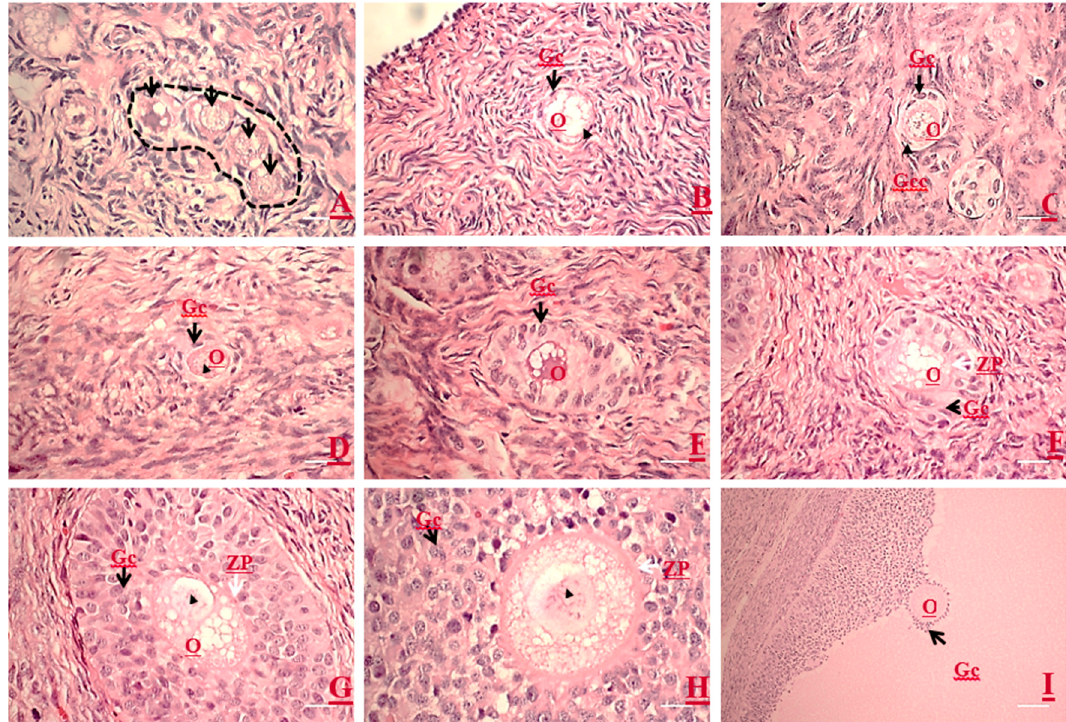
Figure 1. Microscopic morphologies of growing oocytes, follicles, and the associated follicular cells at different stages of folliculogenesis by using semi-thin sections of porcine ovaries. ( A ) A cluster of primordial follicles (enclosed in dot line) is observed in the cortex area. ( B ) Note the flattened granulosa cells (Gc) (arrow) are surrounding an immature oocyte, and the oocyte contains an eccentrically localized nucleus (arrowhead). ( C ) An activated primordial follicle: an oocyte is surrounded by two types of granulosa cells, i.e., cuboidal granulosa cells (arrow) at one pole and flattened granulosa cells (arrowhead). ( D ) A primary follicle oocyte is surrounded by a single layer of cuboidal granulosa cells (arrow), and the oocyte contains an eccentrically localized nucleus (arrowhead). ( E – H ) An early secondary follicle is transforming into a late stage secondary follicle with the onset of zona pellucida (ZP) formation (white arrow). Note that the increasing layers of cuboidal granulosa cells can be observed with no ZP structure ( E ), and all oocytes possess an eccentric germinal vesicle (GV nucleus, arrowhead). A very thin ZP ( F ) starts to form (white arrow). ( G ) The ZP is getting thicker as the granulosa layers increased. The granulosa cells start getting loosening while the ZP is thickening. ( I ) A tertiary follicle shows multiple layers of polar granulosa cells, antrum, and an eccentric cumulus–oocyte complex (COC). O, oocyte. Magnification: 100 × (Scale bars, 100 µ m) ( A , B , D ; E – G ); 200 × (scale bars, 50 µ m) ( C , H ); and 40 × (scale bar, 250 µ m) ( I